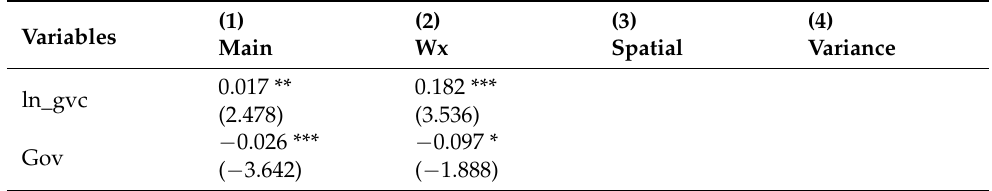
Table 8. Spatial regression